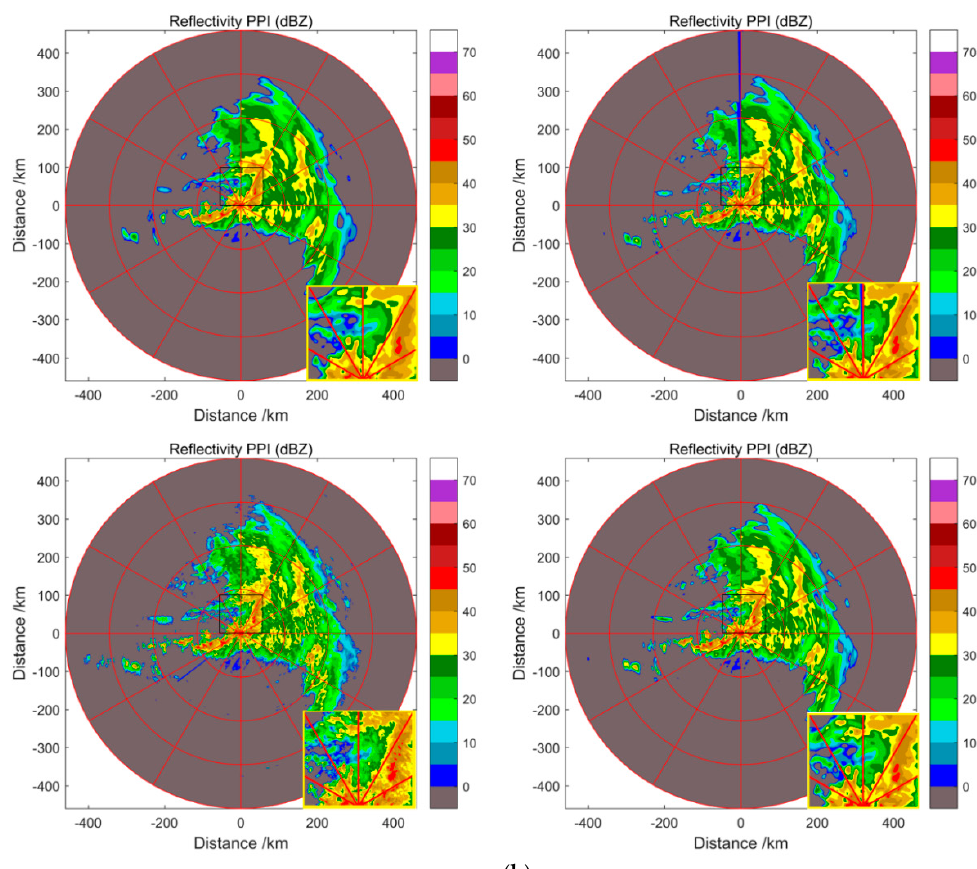
Figure 5. Radar echo reconstruction comparison on reflectivity data. ( a ) 2 × reconstruction of reflectivity data. From left to right and top to bottom: bicubic interpolation echo, the reconstructed echo by IBP [13] (PSNR = 35.3572; SSIM = 0.9556), original radar echo, and the reconstructed echo by the proposed NSSR algorithm (PSNR = 37.3138; SSIM = 0.9609). ( b ) 4 × reconstruction of reflectivity data. From left to right and top to bottom: LR radar echo, the reconstructed echo by IBP [13] (PSNR = 30.5857; SSIM = 0.8656), original radar echo, and the reconstructed echo by the proposed NSSR algorithm (PSNR = 33.5267; SSIM = 0.9062). The tested data is the first elevation cut of the CINRAD SA radar at 11:24 (BJT) on 18 August 2018.